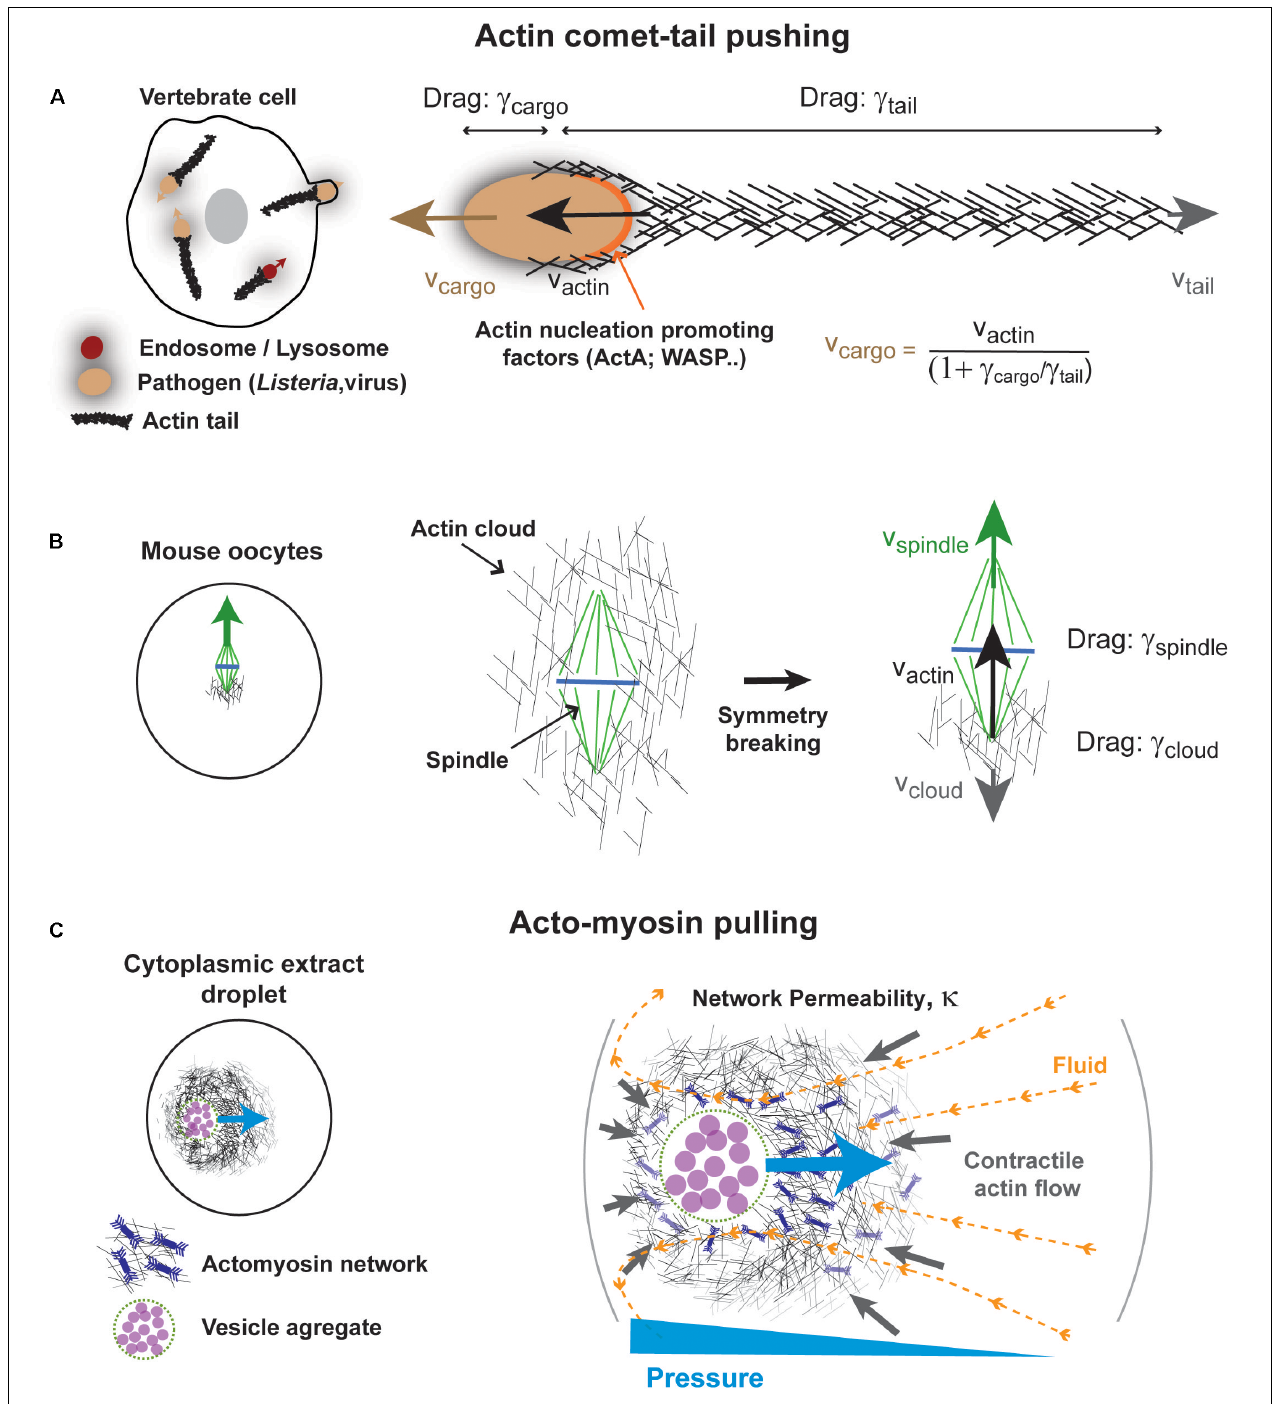
FIGURE 4 | Some mechanisms for actin-based force exertion in bulk. (A) Actin comet tail model for actin based cytoplasmic pushing. Comet tails grow at the surface of different microbes, such as Listeria monocytogenes , or even at the surface of intracellular vesicles. Actin polymerization promoted by local actin regulators such as ActA for Listeria and Wasp for lysosomes promotes the growth of a branched actin network, by activating host arp2/3 complex. Assuming pure viscous interactions of both cargos and tails with the cytoplasm, the propulsive speed of the cargo is linked to that of actin growth speed by their drag ratio as indicated. (B) Meiotic spindle asymmetric displacement in mouse oocytes. An actin cloud forms around spindle and chromosomes as a result of formin-nucleation activity around spindles or chromosomes. This cloud breaks symmetry and pushes the spindle upward invoking similar physical principles as for comet-tails. Modified from Li et al. (2008). (C) Self-organized acto-myosin contractile networks in extracts encapsulated in droplets can drive actin and fluid flows. Darcy flows through the permeable network create a pressure gradient that pushes the network toward the cell center. Modified from Ierushalmi et al. (2019).